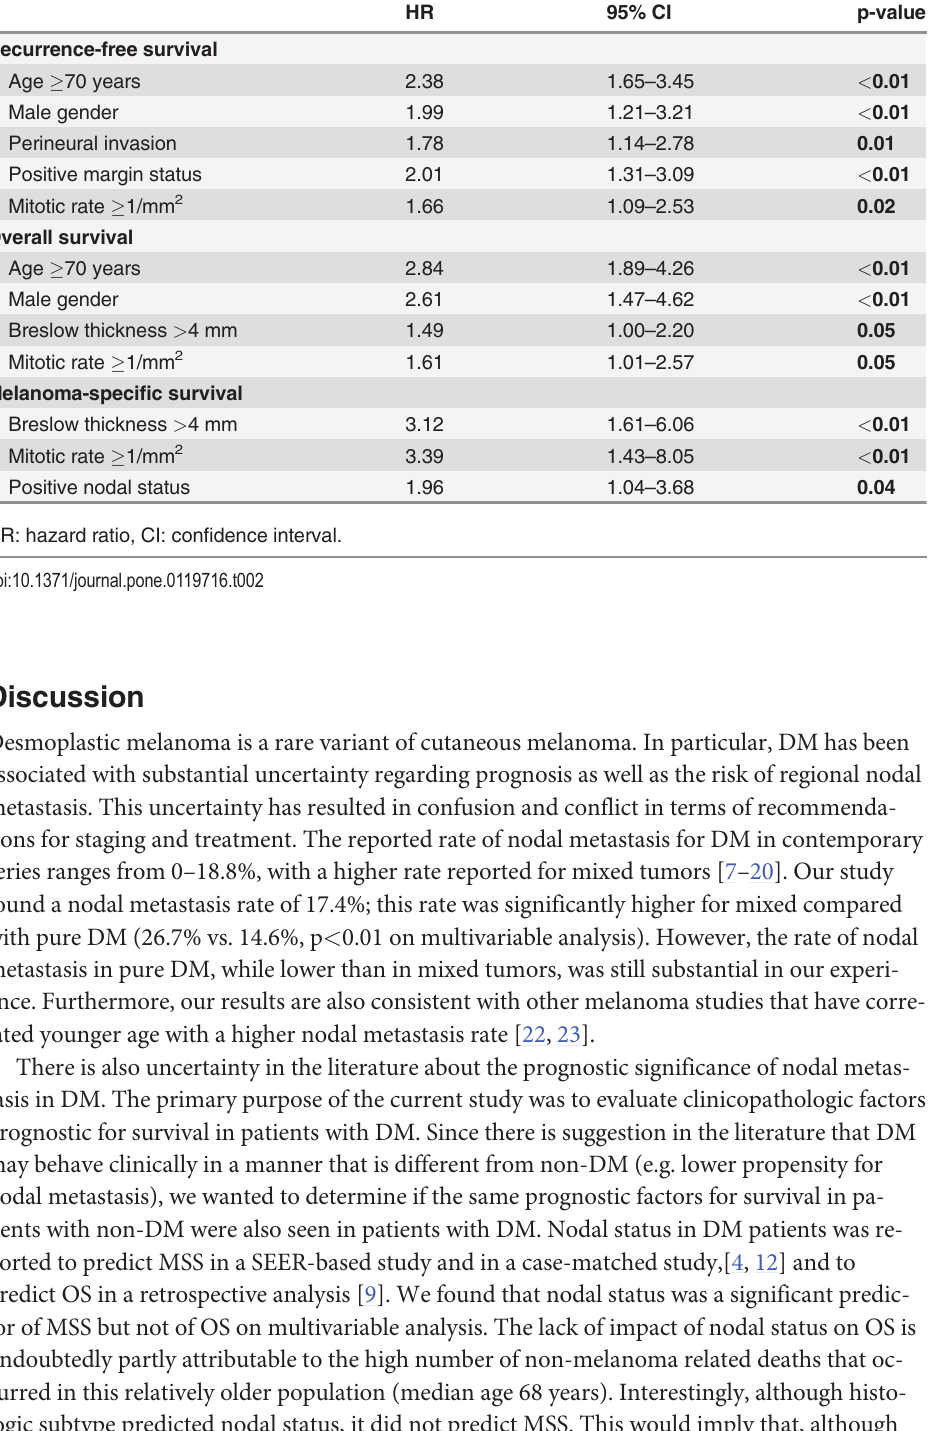
Table 2. Multivariable analysis for predictors of survival in patients with clinically localized desmoplastic melanoma. HR 95%